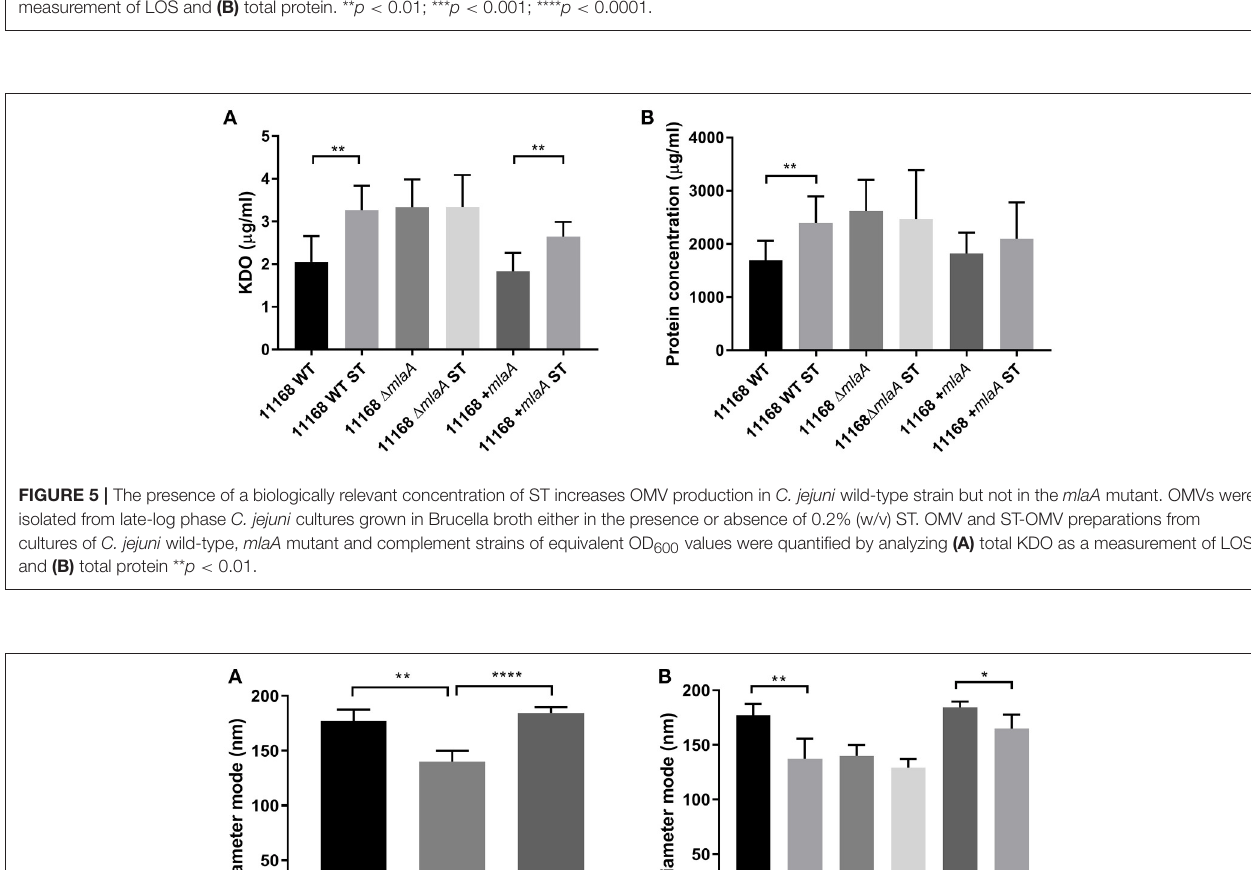
Frontiers in Cellular and Infection Microbiology |